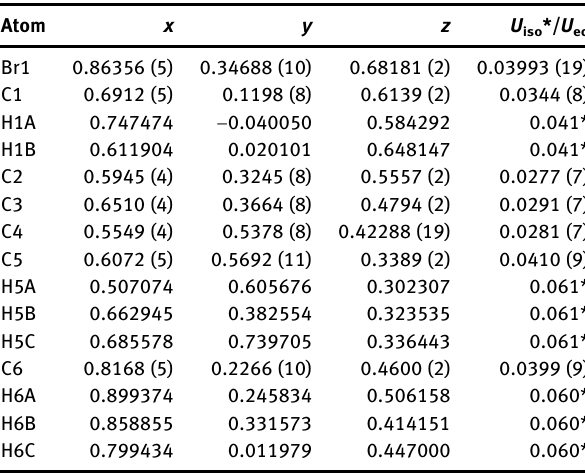
Table  : Fractional atomic coordinates and isotropic or equivalent isotropic displacement parameters (Å 